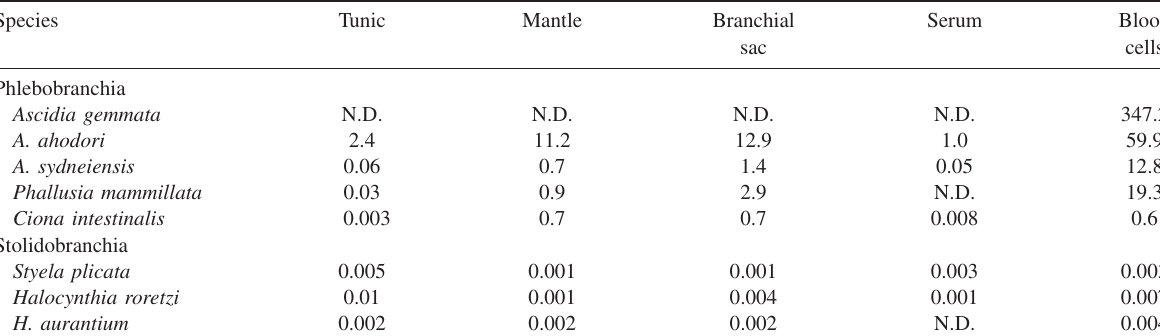
Table 1 Concentrations of vanadium in the tissues of several ascidians (m M ).